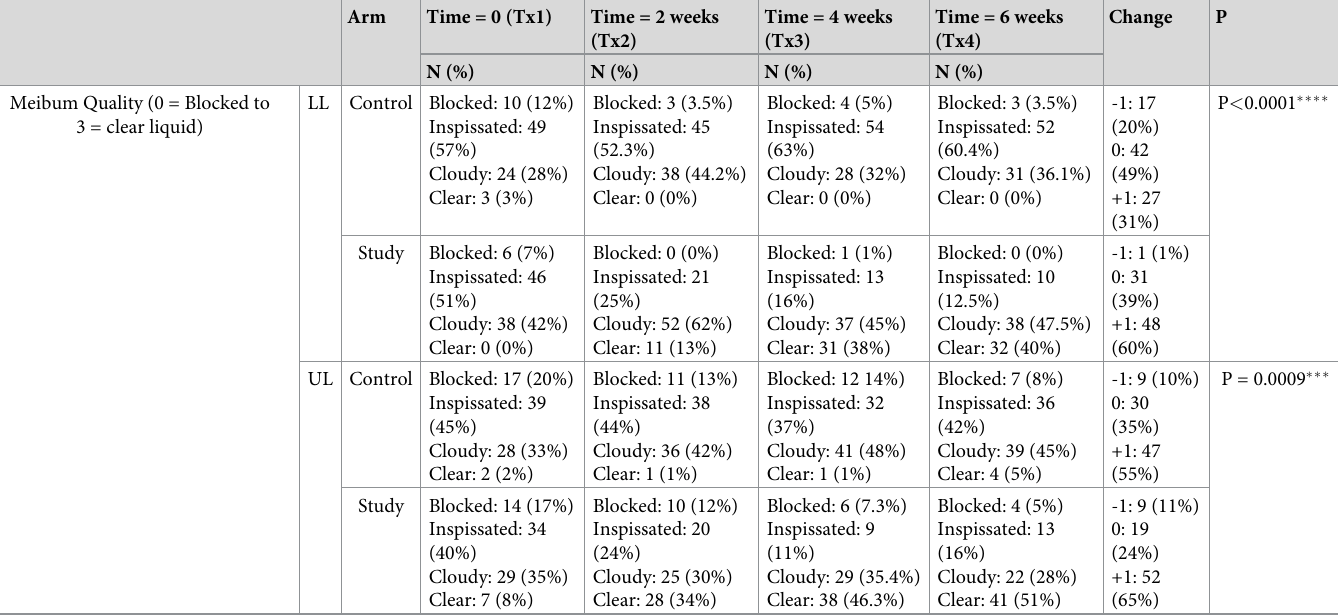
Table 5. Categorical outcome measures tested after every treatment session.